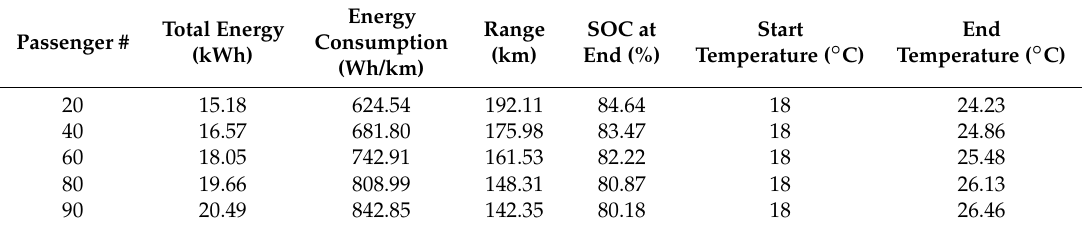
loading Table 3. Energy consumption of the electric drive system depending on the changes in the bus loading status.